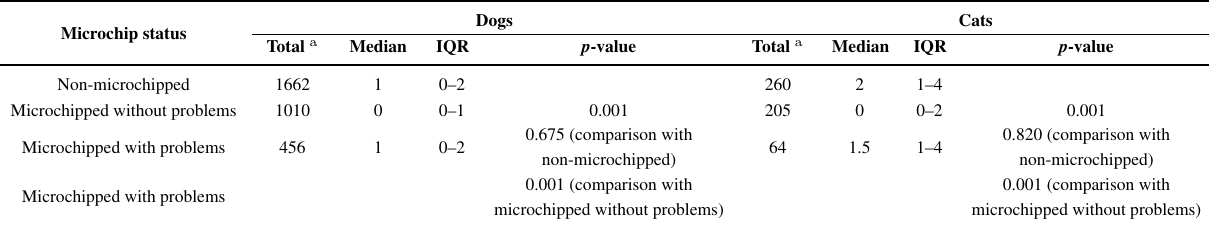
Table 7. Number of nights spent at shelter before reclaim for stray adult dogs and cats admitted to RSPCA-QLD shelters (January 2012–December 2013) and Mann-Whitney pairwise comparisons of microchip status